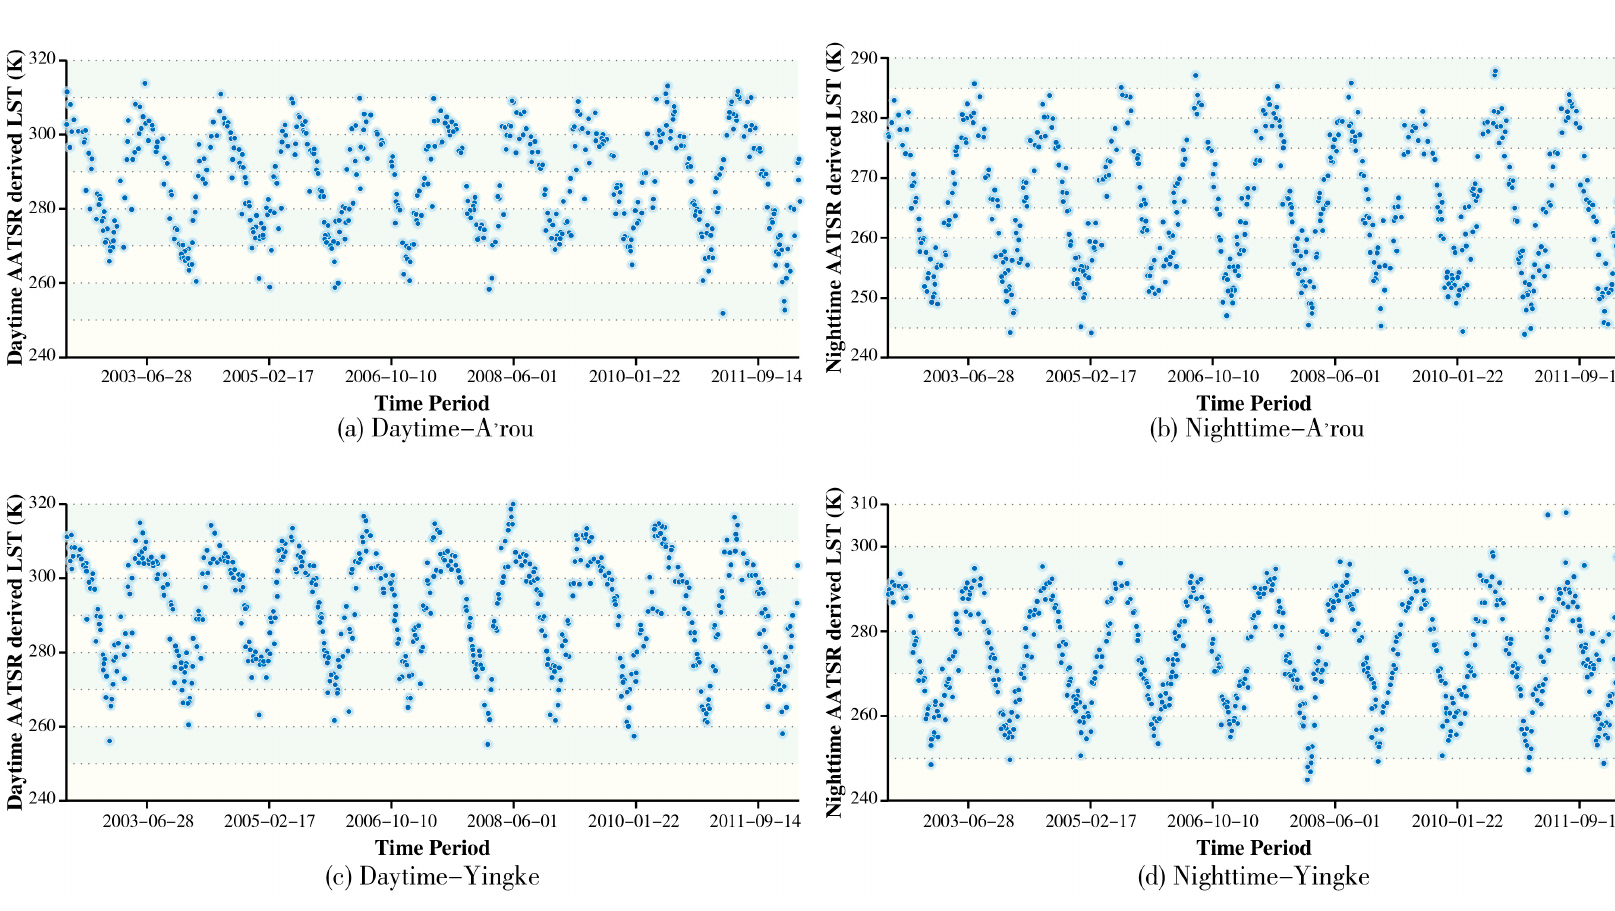
Figure 4. Annual phase of AATSR-derived LST at A’rou and Yingke site during daytime and nighttime for 2003–2011: ( a ) daytime LST series at A’rou site; ( b ) nighttime LST series at A’rou site; ( c ) daytime LST series at Yingke site; ( d ) nighttime LST series at Yingke